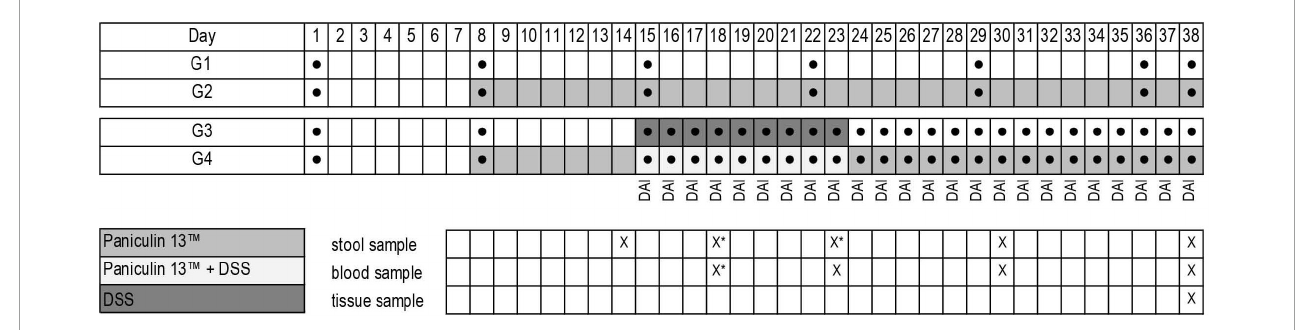
FIGURE1 Experimental design of the study. Experimental groups (G1, G2, G3, G4); weight determination • ; Paniculin 13 TM administration; DSS treatment; DAI score; collection date and time of stools, blood and tissues are indicated in the grid (x). *Stool samples on days 18 and 23 were collected only for mice of G3 and